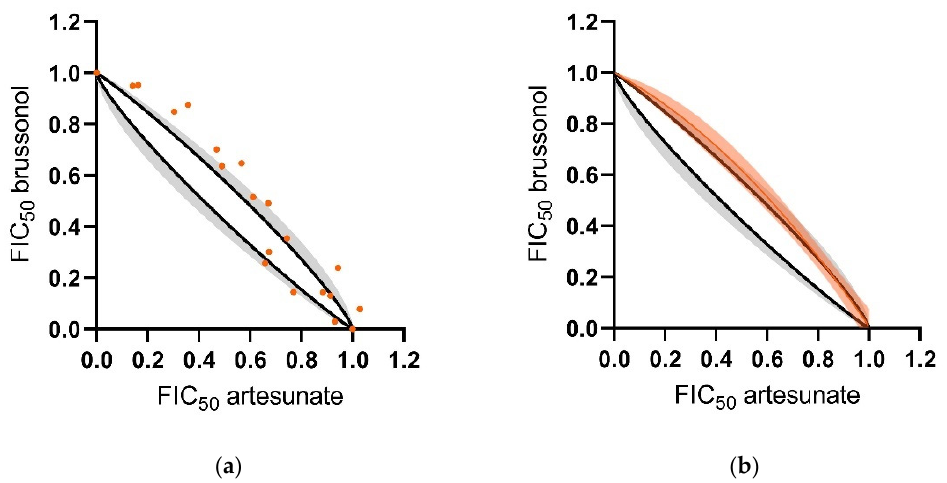
Figure 6. Isobologram and additive isobole were calculated for the combination of brussonol with artesunate. Black lines correspond to the arithmetic average of the upper and lower limits of the additive area, and the gray area indicates the calculated standard deviations. ( a ) Experimentally determined FIC 50 value pairs are individually represented as orange dots. ( b ) Non-linear fit of experimental data, indicated by the fitted curve (dark orange) and the confidence interval of 95% (clear orange). Data analyzed are from three independent experiments.